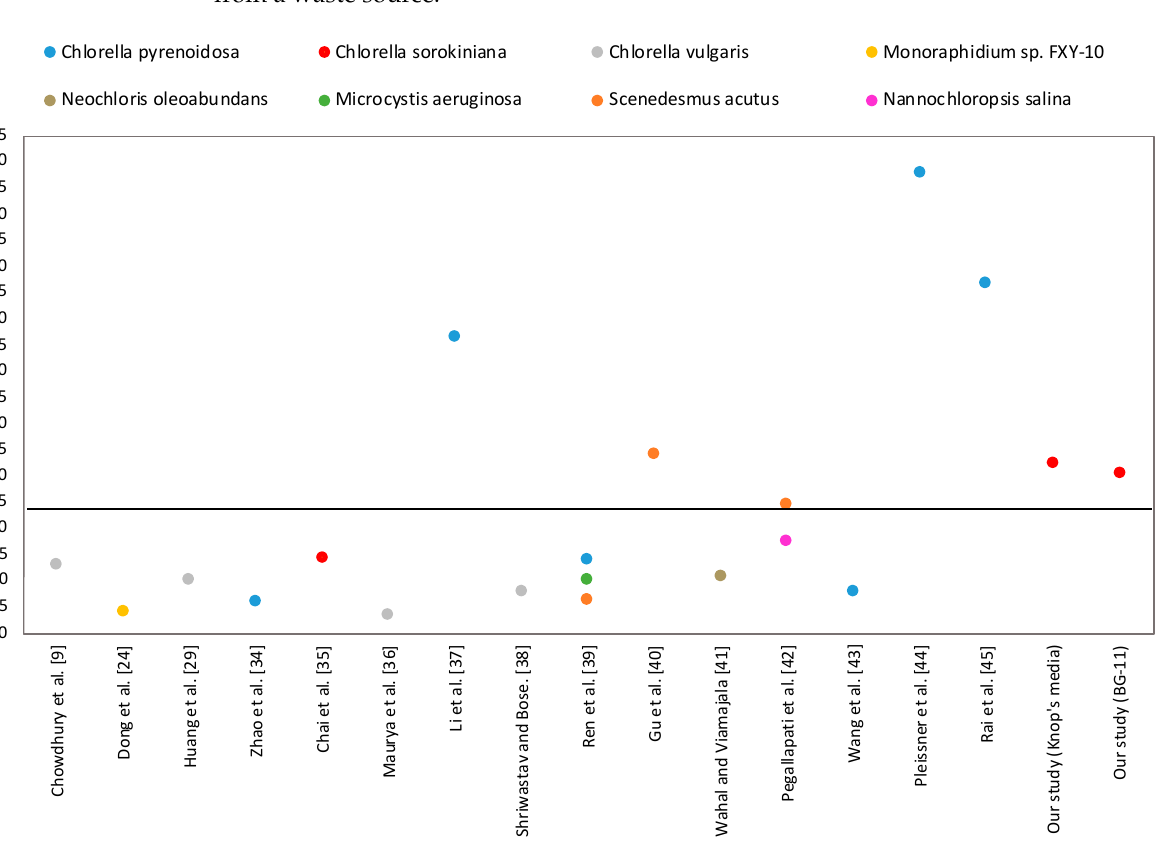
Figure 1. Comparison of biomass productivity of different algal species [9,24,29,34–45] with the present study (dashed line represents the average value).